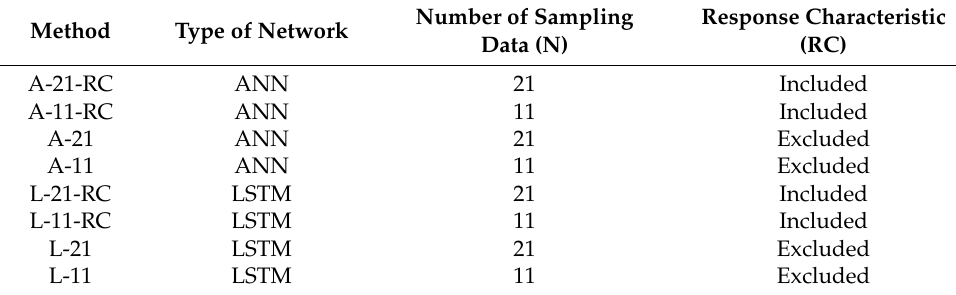
Table 1. Learning method classified by the type of network, number of sampling data, and whether response characteristics were included as inputs. ANN and LSTM are abbreviated as “A” and “L”, respectively. The numbers “21” and “11” indicate the number of sampling data. “RC” indicates if the input included or excluded the response characteristics. If the name of the method does not end with “RC,” then the input of that method did not include response